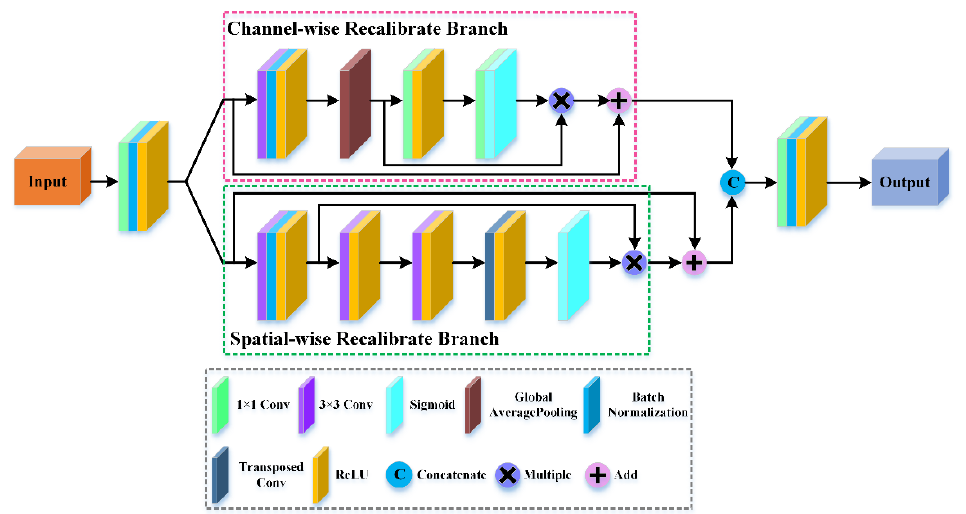
Figure 3. The structure of the distillation block (DB).